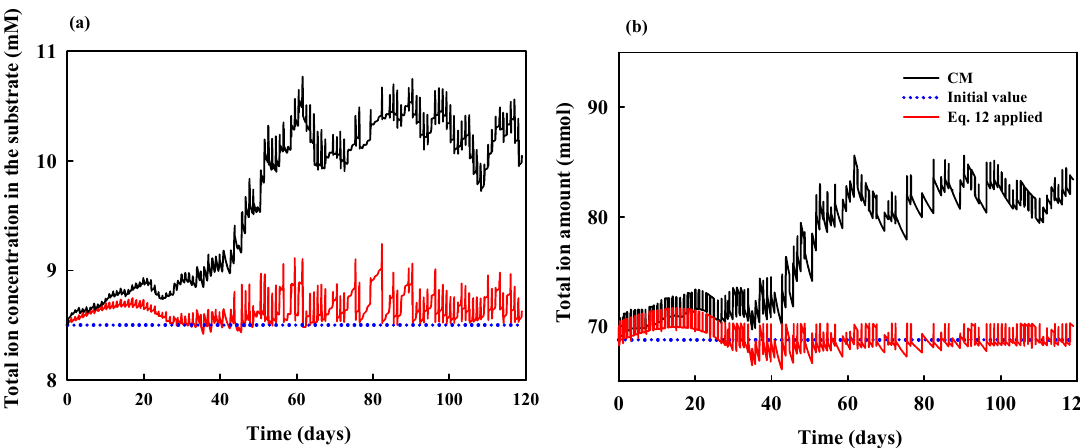
Figure 2. Changes in total ion concentration in the substrate ( a ) and total ions in the system ( b ) in the closed-loop soilless culture system using conventional (CM) and alternative (Equation (12) applied) nutrient-replenishment methods.